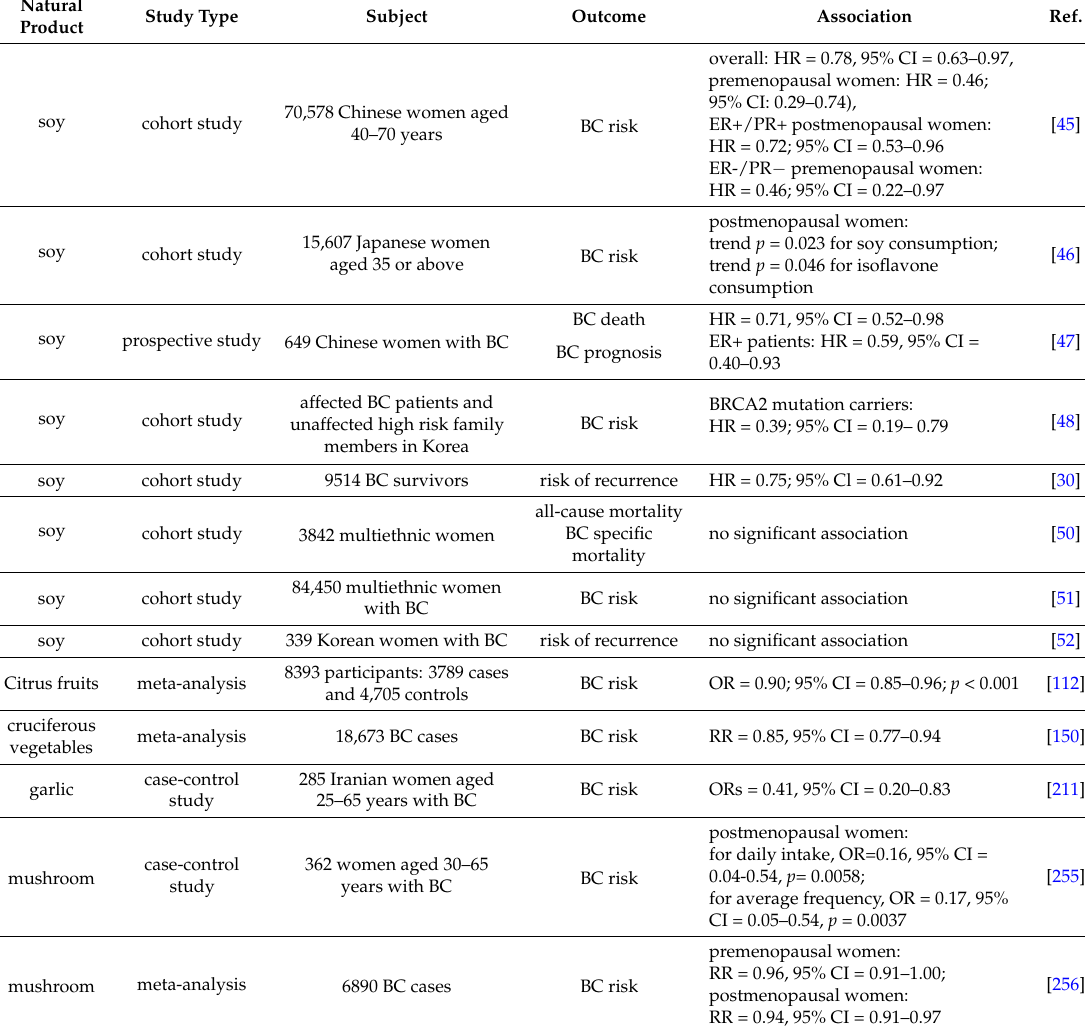
Table 1. Epidemiological studies on association between natural product intake and breast cancer.